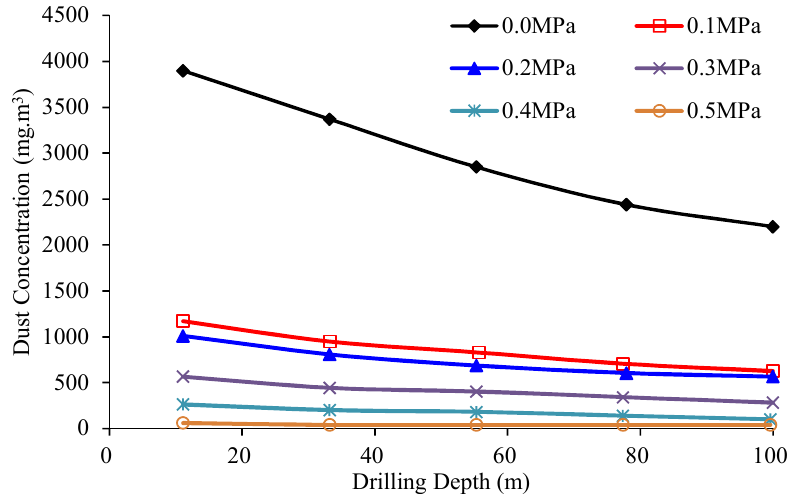
Figure 7. The dust concentration at different drilling depths.